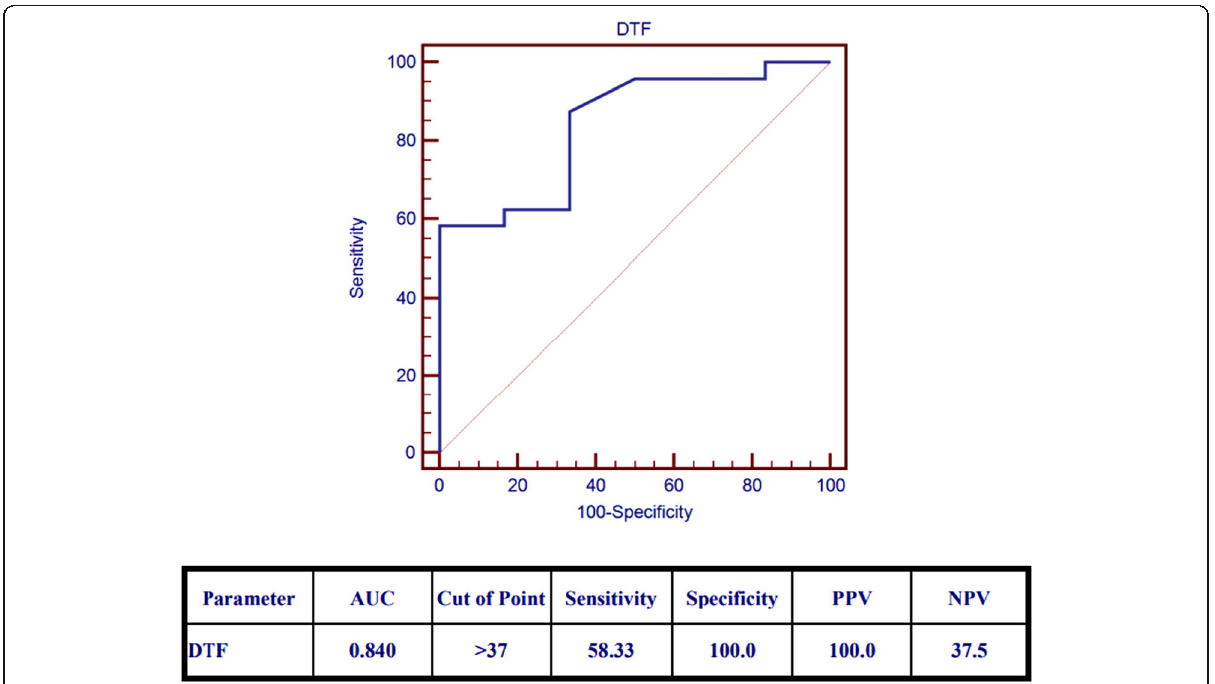
Fig. 5 Receiver operating characteristic curve (ROC) for diaphragmatic thickness fraction to differentiate between successful weaning and weaning